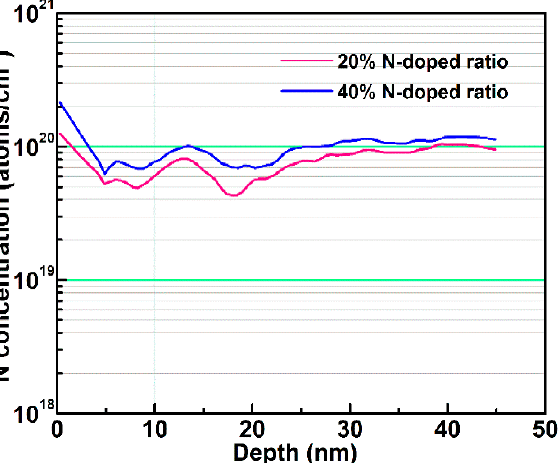
Figure 3. O 1s XPS spectra of the annealed a-IGZO films grown using N-doping ratio of ( a ) undoped,